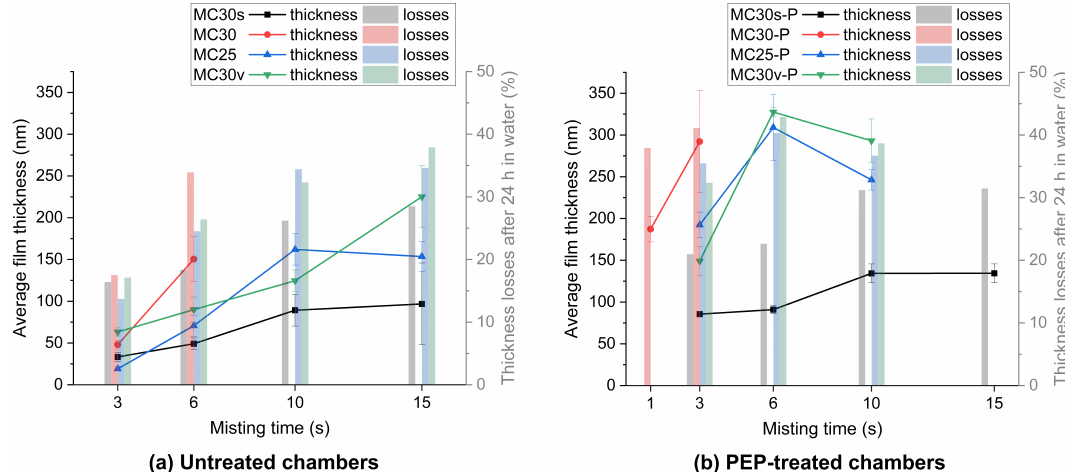
Figure 6. Average thickness (left Y axis, lines) of as-deposited plasma-polymerized films and their thickness losses after 24 h of immersion in water (right Y axis, bars), obtained before ( a ) and after plasma-electrolytic polishing ( b ), with different misting times. Pump speed S50, plasma polymerization time 16 s. Data acquired by ellipsometric measurements. Note: for certain mist chambers, the data for some misting times could not be obtained because the amount of misted liquid was too high to achieve a polymerized thin film within the specified plasma polymerization time. In the case of MC30-P, pp films with misting time of 1 s were acquired to have more data